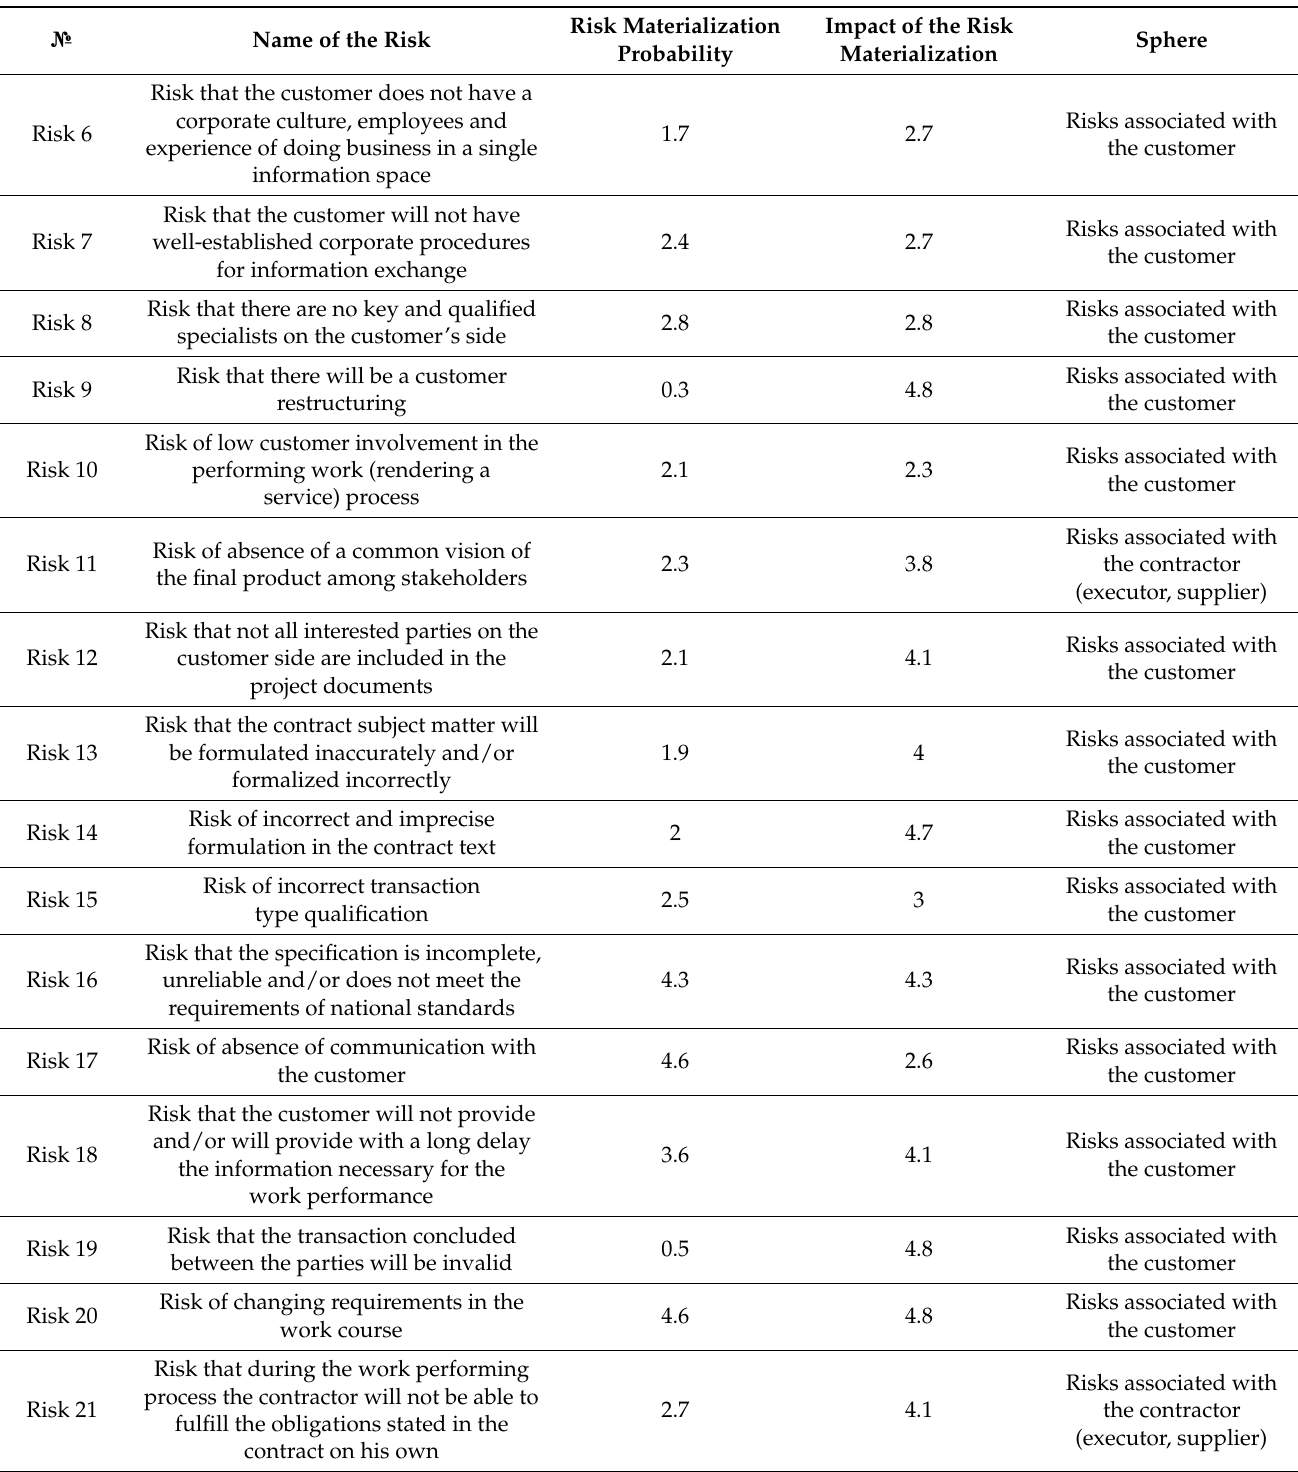
Table 6. Compliance risks of IT